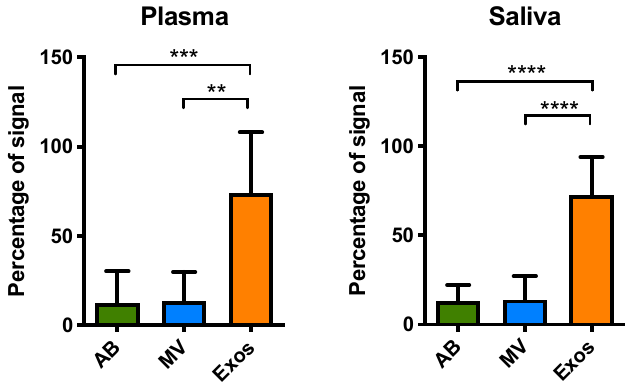
Figure 6. Distribution of EGFR mutations (both exon 19-del and L858R) in isolated EVs from di ff erent biofluids. Di ff erent EV fractions including apoptotic bodies (AB), microvesicles (MV), and exosomes (Exos) were isolated from the individual or pooled biofluid samples. The samples that had been previously identified as mutated and had a volume of more than 0.5 mL were chosen for isolation of extracellular vesicles (EVs). Samples with less volume were pooled for EVs isolation. We fractionated EVs from plasma (nine patients and one pooled set) and saliva (four patients and four pooled sets) with detectable EGFR L858R or exon 19-del mutations. The exon 19-del and L858R mutation detection assays were performed with EFIRM. Plasma ( n = 10), saliva ( n = 8). ** means p < 0.01, *** means p < 0.001, **** means p < 0.0001